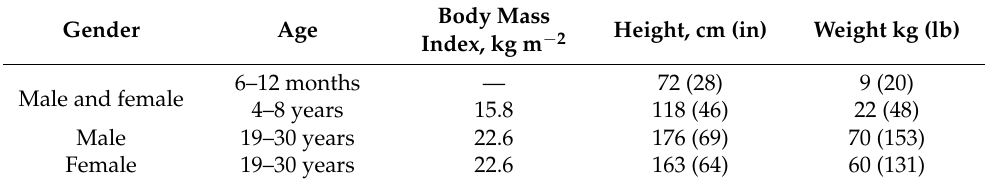
Table 2. Average weight, height, and body mass for different age groups used to determine the RDA/RAI for different essential nutrients is taken from U.S. National Academy of Sciences [33]. Body Gender Age